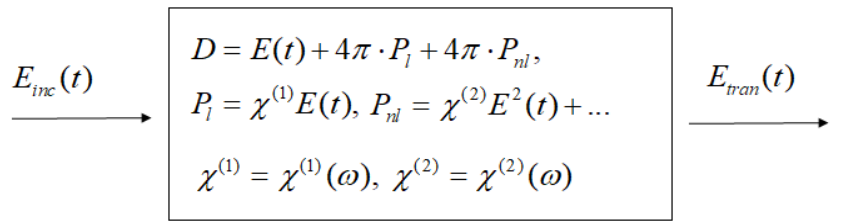
E t is the incident electric inc